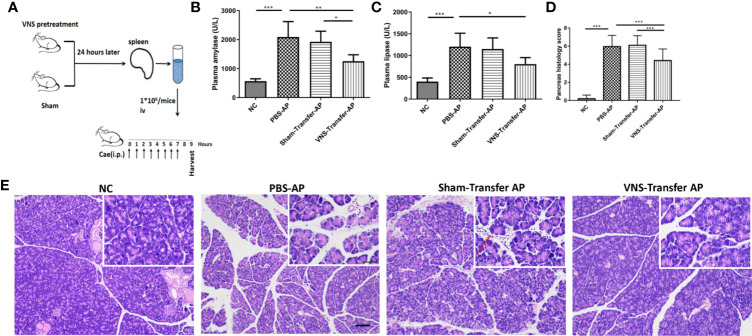
Adoptive transfer of splenocytes from VNS-treated mice protects against pancreatitis in naive recipient mice. (A) Donor mice underwent VNS or sham treatment. Twenty-four h later, splenocytes isolated from donor mice were injected iv into recipient mice. Twenty-four h after splenocyte transfer, the recipient mice were subjected to caerulein-induced pancreatitis. Mice were harvested 2 h after the eighth caerulein injection. (B) Plasma amylase. (C) Plasma lipase. (D) Pancreas histological score. (E) Representative H&E staining of pancreas sections. Red arrow represents infiltrating cells. Scale bars: 100 μm; 50 μm (inset). Values are shown as means ± SE. n = 6. *p < 0.05, **p < 0.01, ***p < 0.001. VNS vagus nerve stimulation, iv intravenous, Cae caerulein, i.p. intraperitoneal, NC normal control, AP acute pancreatitis.